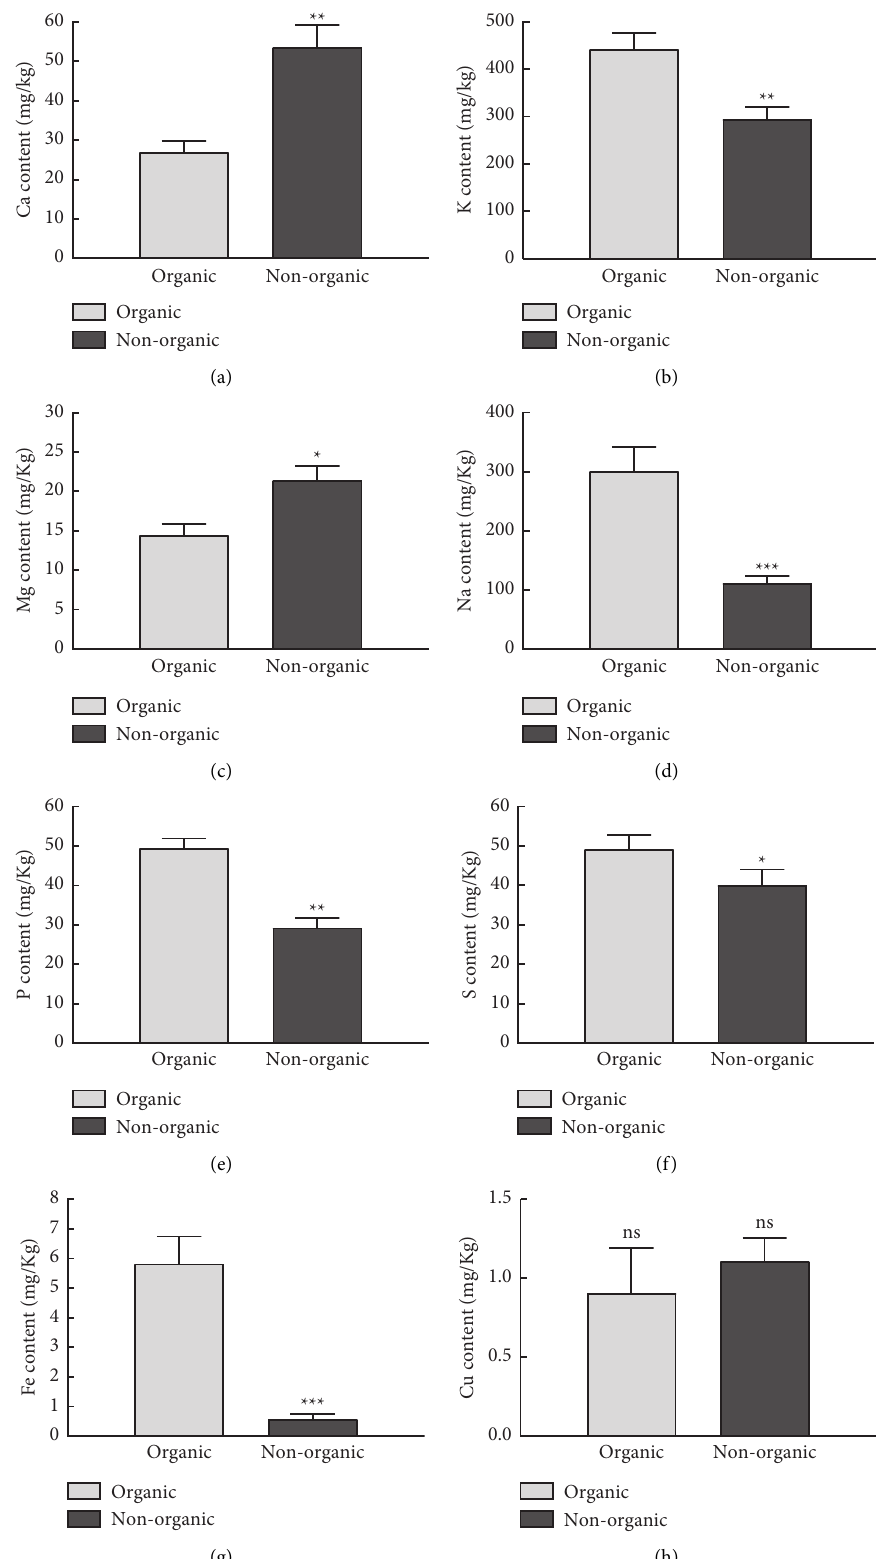
Figure 5: Mineral content of both organic and nonorganic vegetable soups at 0h, 24h, 48h, 72h, and 96 h. Each data point is the mean of triplicated data with ± SE. The bars represented with “ ∗ , ∗∗ , or ∗∗∗ ” are significantly different at p � 0 . 05, p � 0 . 01, and p � 0/001, re- spectively. The bars represented with “ns” are nonsignificant at p � 0 .